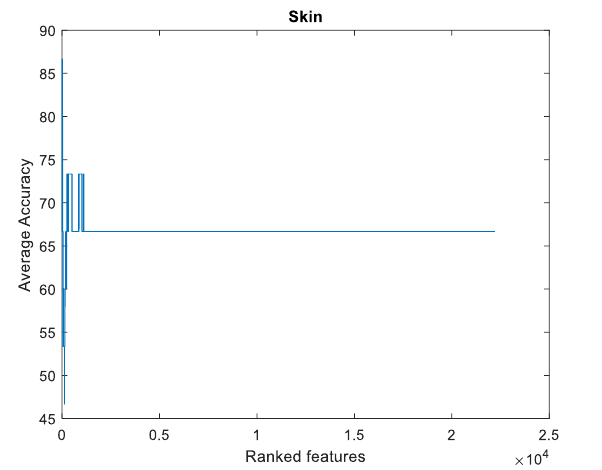
Fig. 4. The average accuracy of the ranked features for skin cancer dataset.